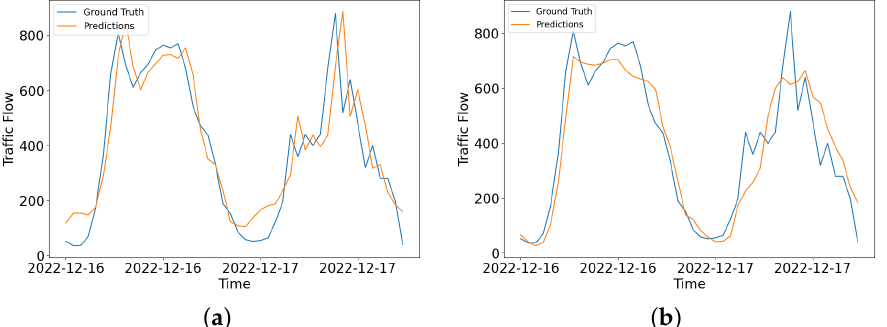
Figure 4. Visualizations of prediction results for the forecasting horizon of 3 h for sensor MS109: ( a ) Temporal Graph Convolutional networks (TGCN), and ( b ) Diffusion Convolutional Recurrent Neural Network (DCRNN).